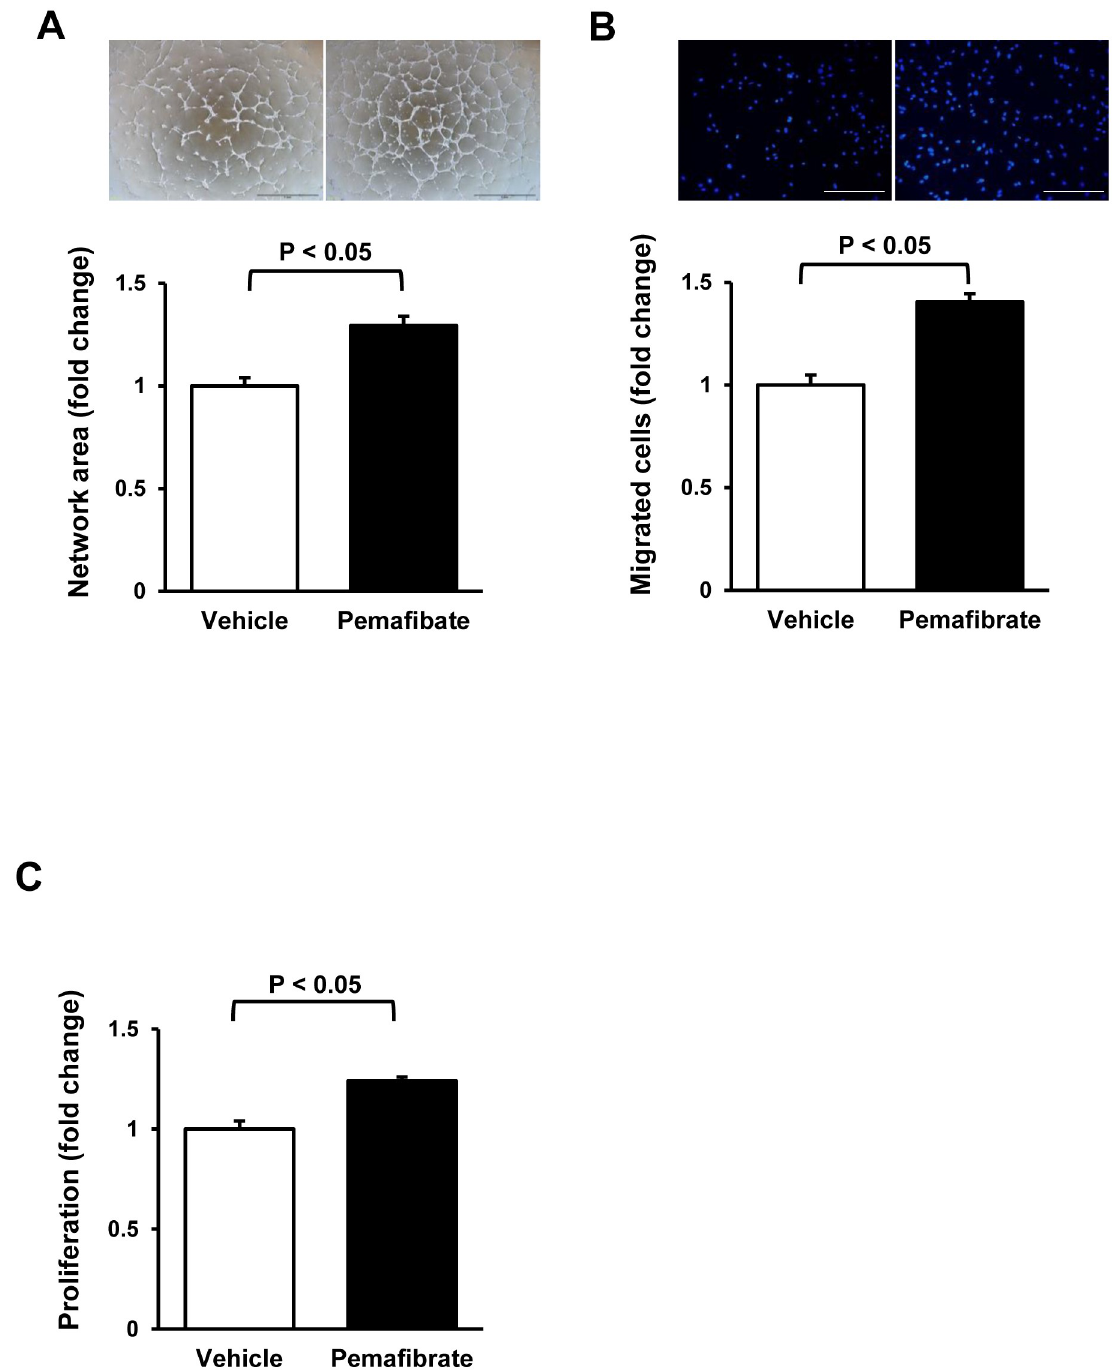
Fig 2. Pemafibrate promotes endothelial cell function in vitro. A . Endothelial cell network formation after treatment with pemafibrate. Upper panels show the representative photos of network formation of HUVECs at 16 h after treatment with pemafibate (10 nM) or vehicle. Lower panel shows the quantitative analysis of network area. N = 4 in each group. Scale bars show 1 mm. B . The number of migrated HUVECs at 8 h after treatment with pemafibrate (10 nM) or vehicle. Upper panels show the representative photos of DAPI staining of migrated HUVECs. N = 6 in each group. Scale bars show 200 μ m. C . Proliferative activity of HUVECs at 24 h after treatment with pemafibrate (10 nM) or vehicle. N = 8 in each group.